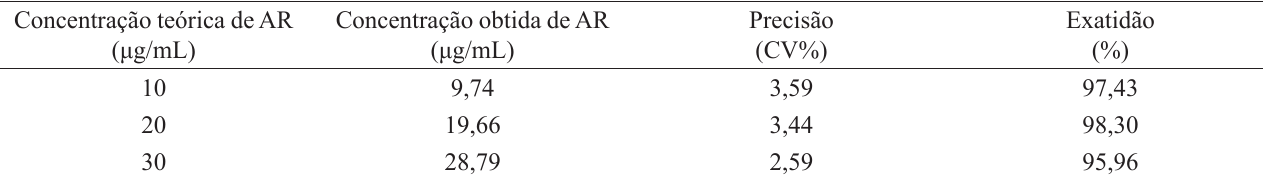
Os resultados referentes à avaliação da precisão e da exatidão inter e intra-ensaio para o ácido retinóico estão